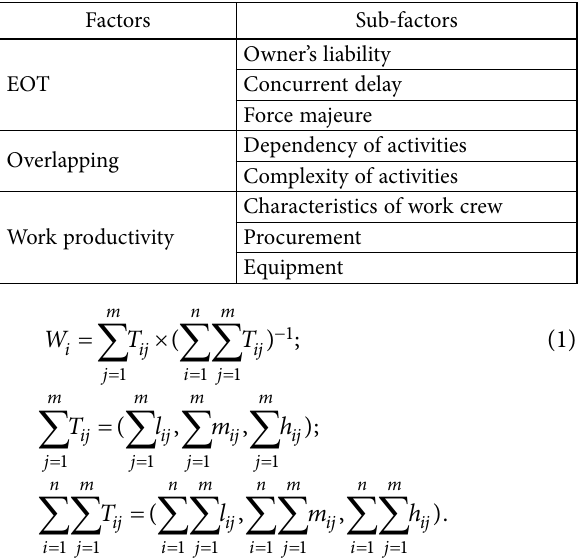
Table 1. The resource reallocation influence